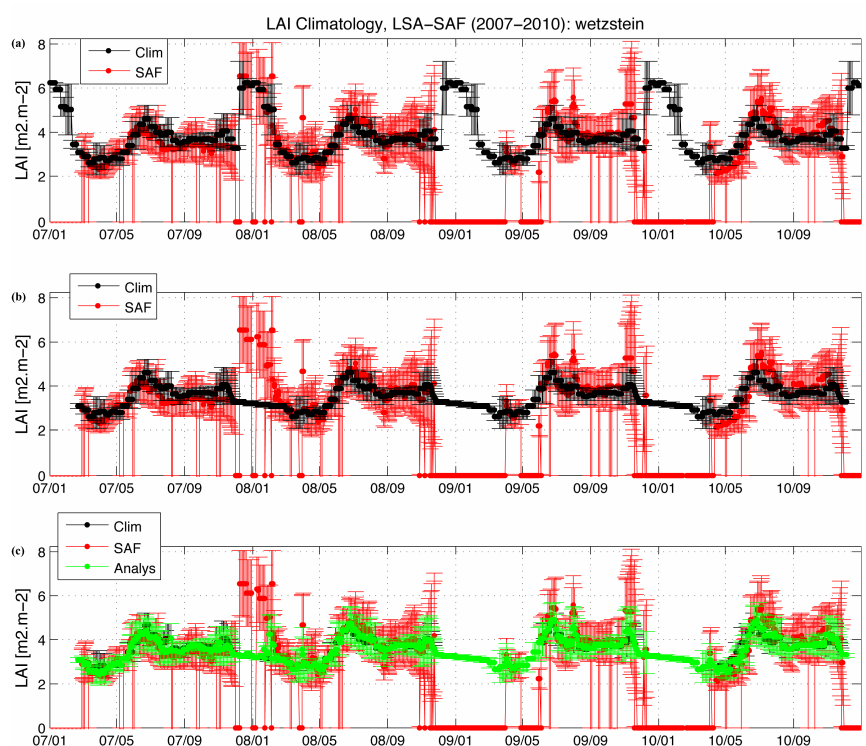
Fig. 5. Illustration of the pre-processing of LSA-SAF LAI images on a test case over a forest (Wetzstein) in Germany. (a) A 10-days composite (black) is derived from LSA-SAF LAI daily data (red). (b) Spurious data are filtered out, and linear interpolation is applied to create the climatology, LAI c (black). (c) At last, an optimal interpolation scheme (OI) is applied using the climatology and the actual LSA-SAF LAI, LAI SAF , to provide the analysed LAI, LAI a .